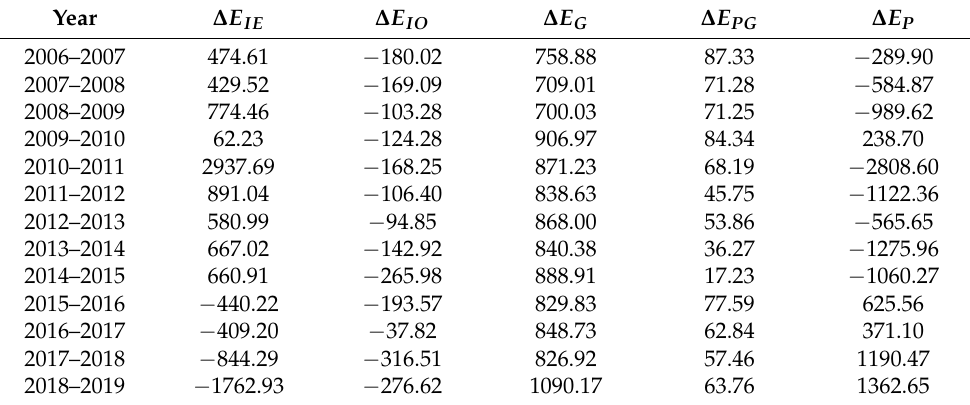
Table 3. Driving factors of electricity consumption change in the YRD region (10 8 kWh).